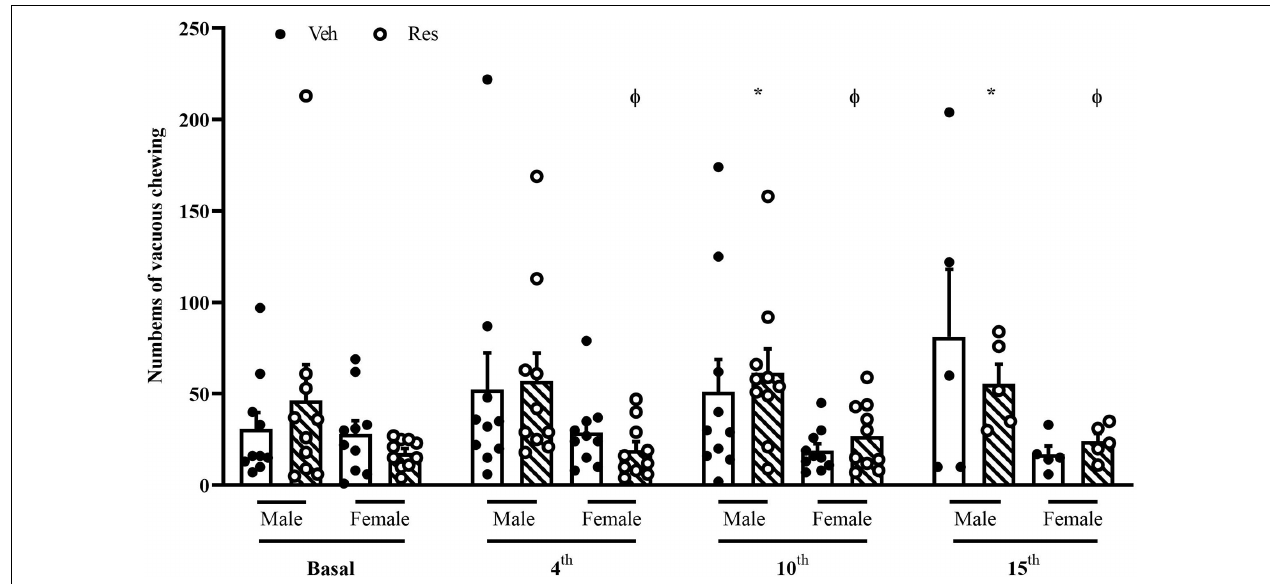
FIGURE 3 | Effects of repeated treatment with 0.1 mg/kg reserpine (Res) or vehicle (Veh) on the vacuous chewing (VCM) behavior in female and male rats. * p < 0.05 comparing Res and Veh and φ p < 0.05 comparing Male-Res and Female-Res (Two-way repeated-measure ANOVA followed by Sidak’s post hoc test). Values were expressed by mean ± SEM. Black and circles represent individual data of Veh and Res animals,